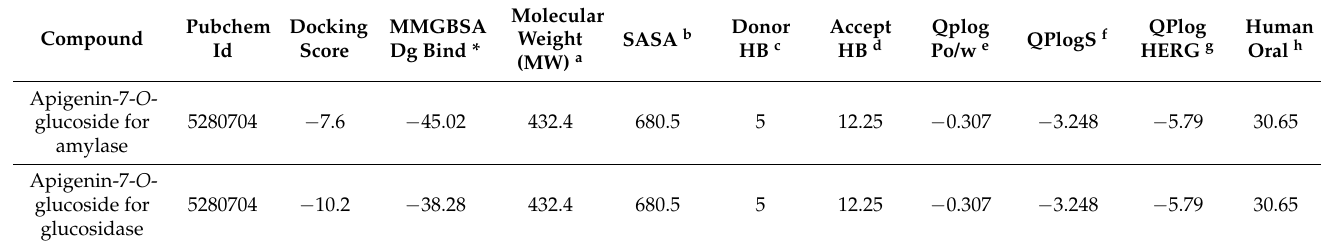
Figure 3. Molecular interactions of selected compound luteolin-7- O -glucoside, ( a ) luteolin-7- O - Figure 3 . Molecular interactions of selected compound luteolin ‐ 7 ‐ O ‐ glucoside, ( a ) luteolin ‐ 7 ‐ O ‐ glu ‐ glucoside with alpha-amylase, ( b ) luteolin-7- O -glucoside with alpha-glucosidase. coside with alpha ‐ amylase, ( b ) luteolin ‐ 7 ‐ O ‐ glucoside with alpha ‐ glucosidase. Pharmacokinetic and toxicological properties of apigenin-7- O -glucoside calculated from